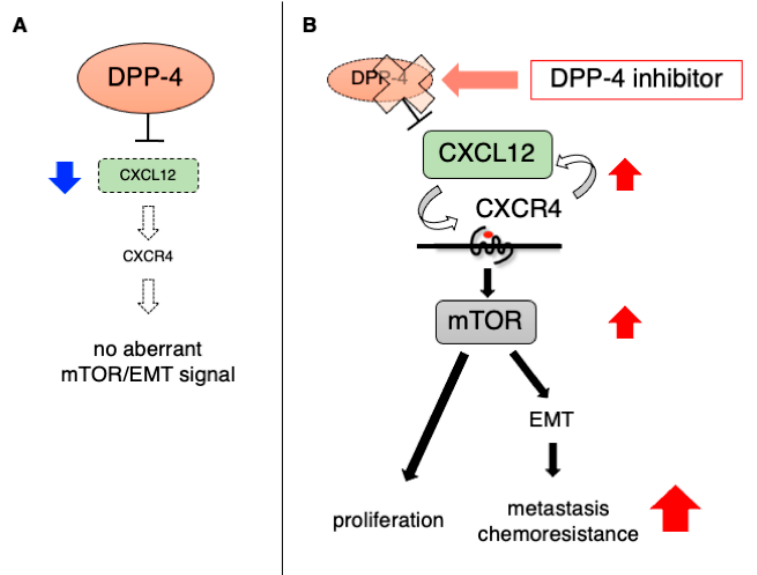
Figure 1. The impact of DPP-4 inhibitor on mammary tumor via CXCL12/CXCR4 downstream